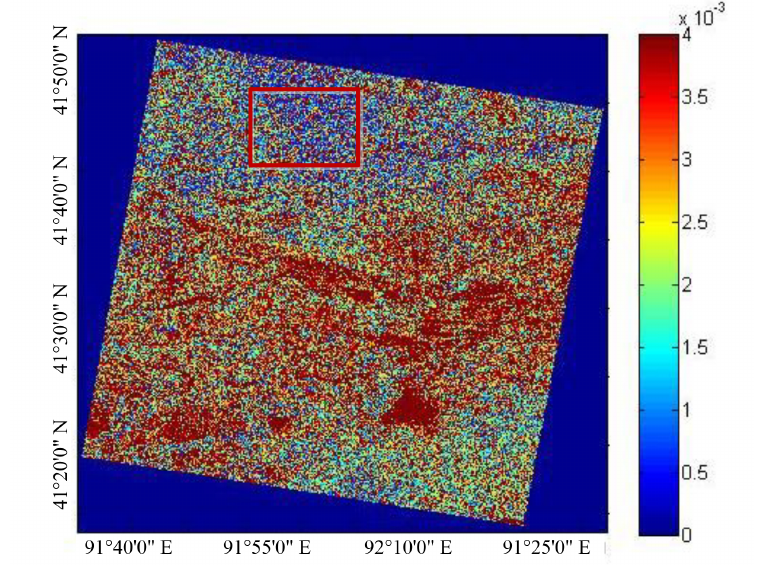
Figure 6. The soil moisture content map of the test